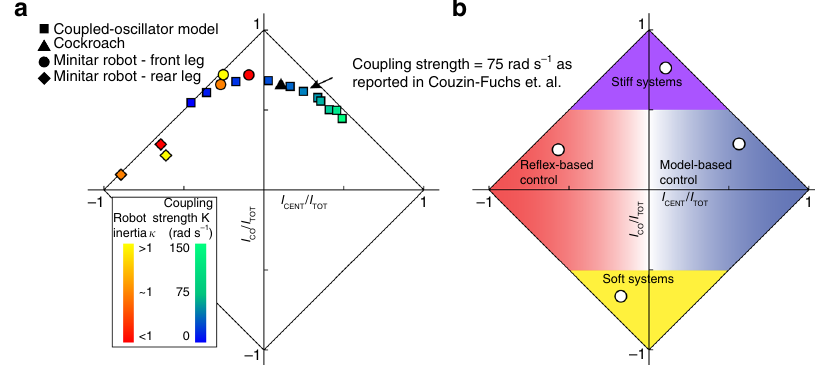
Fig. 6 Centralization/co-information control architecture space. a Centralization and co-information for all systems are plotted here normalized by total information. b Any system will fall within a diamond region bounded by the solid black diagonal lines. Centralized systems, where a control signal is more informative about global states than local states, will fall into the blue region. Conversely, decentralized systems will be more weighted toward local information and fall in the red region. The purple region represents systems with high redundancy, where local and global states carry overlapping information about the control signal. The yellow region represents synergistic systems, where knowing both local and global states together with give more information about the control signal than separately. We have indicated where we hypothesize where types of systems might